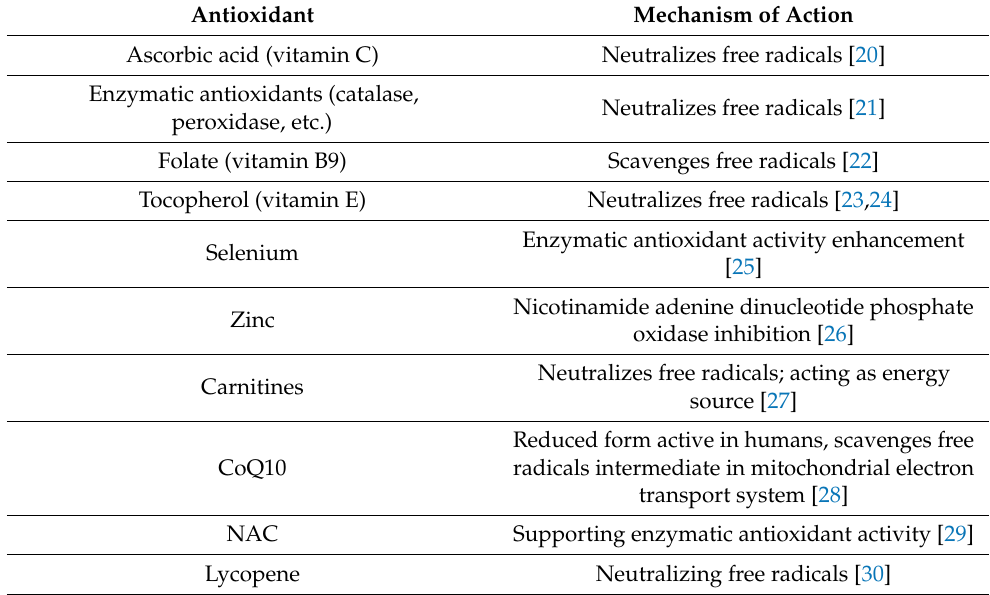
Table 1. Method of action of widely available antioxidants.